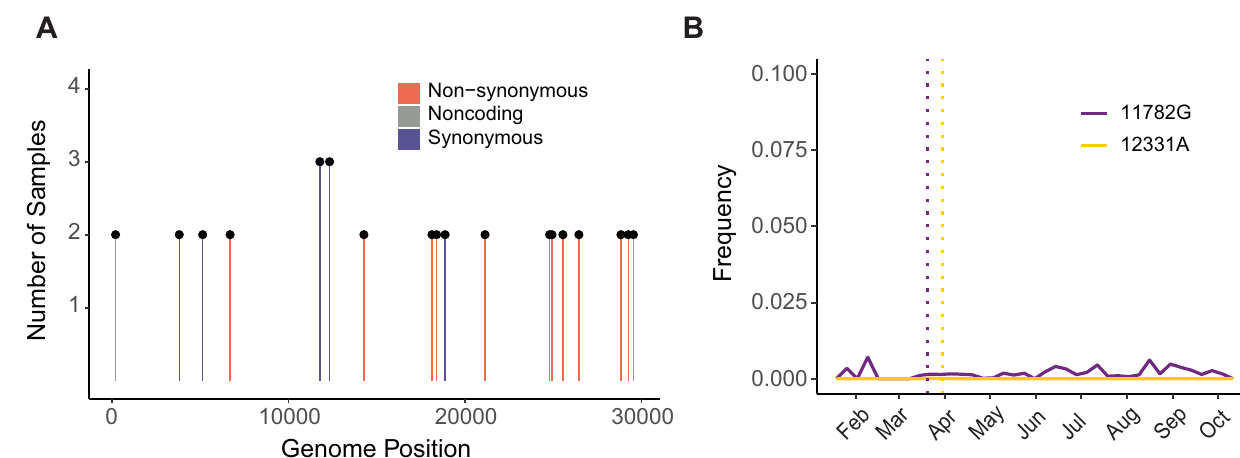
Fig 4. Shared iSNV across samples and their frequency in global consensus genomes. (A) Shared iSNV across samples, with the number of samples sharing the iSNV (y-axis) by the genome position (x-axis). Colors indicate the iSNV coding change relative to the reference. (B) The frequency (y-axis) of three iSNV shared by three or more samples over time (x-axis). The consensus genomes are from GISAID, as available on 2020-11-11. The vertical dotted lines represent the earliest time we detected each iSNV in our samples.